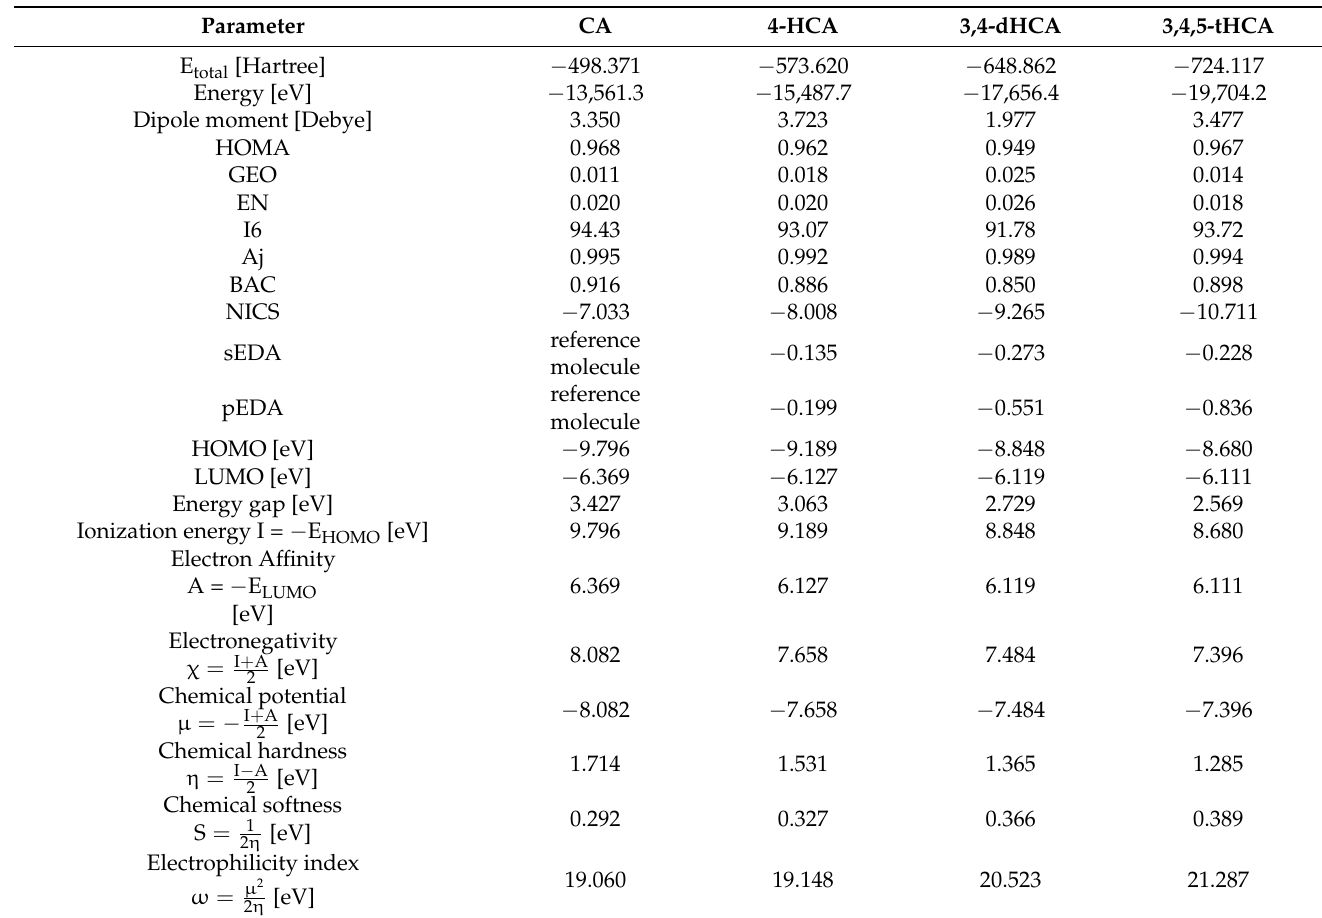
Table 4. Energy parameters and aromaticity indices for CA; 4-HCA; 3,4-dHCA; and 3,4,5-tHCA calculated in B3LYP/6- 311++(d,p). Atoms numbering in Figure